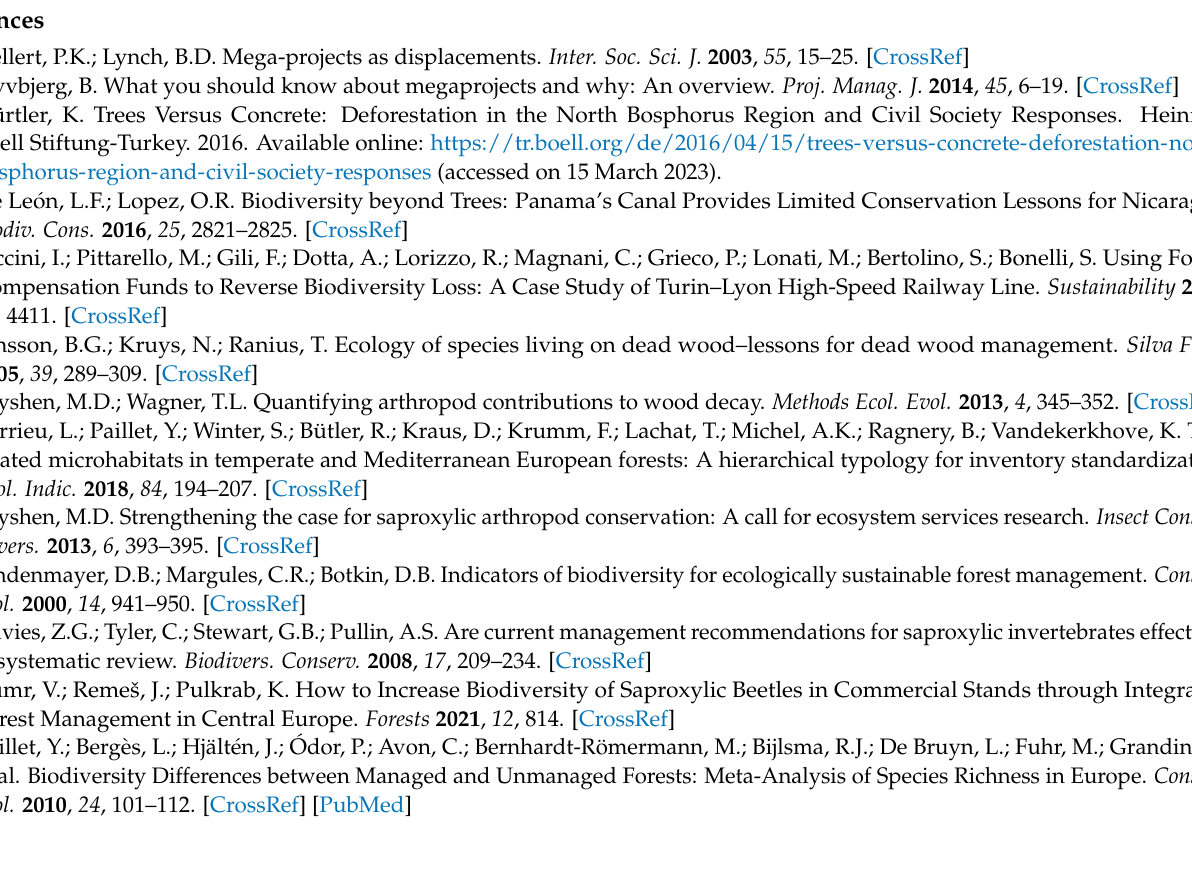
Table S2: Forest variable influence on each PCA axis. Table S3. Forest variables that affect differ- ences between beetle communities in the two sites 1 and 2. Table S4: Results of GLM analysis on species abundance. Table S5: Results of GLM analysis on species richness. Figure S1: PCA results: PCA